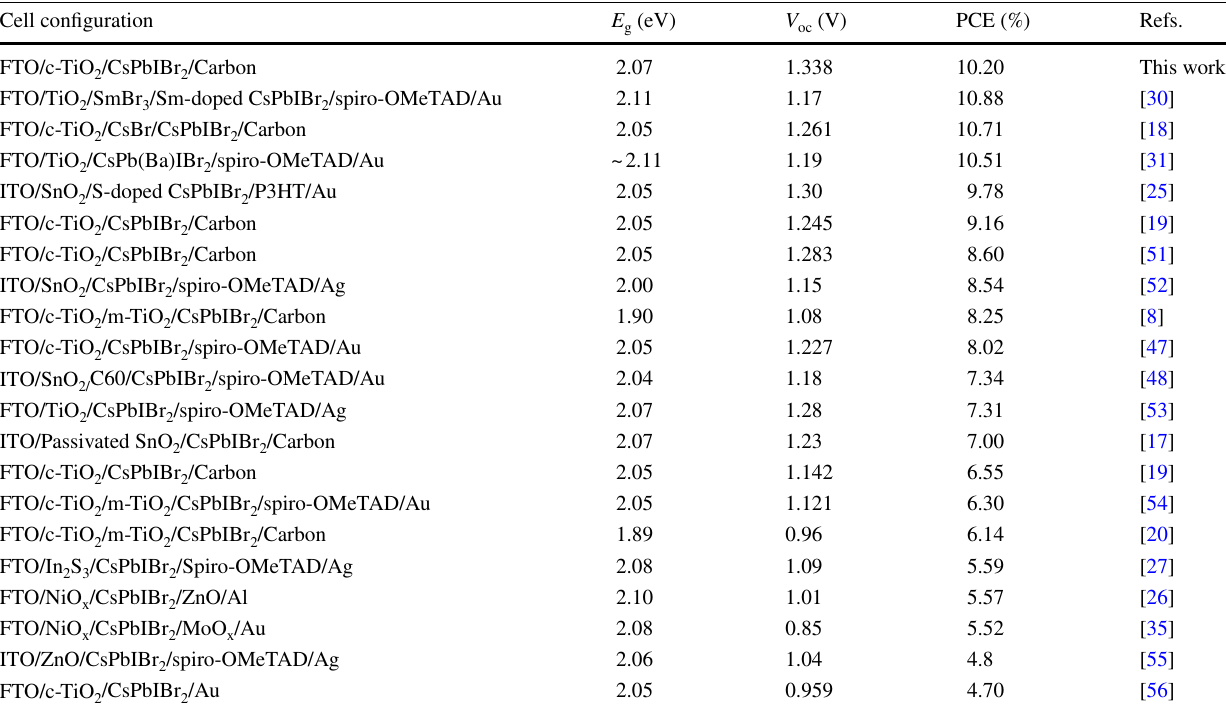
Table 2 Summary of V oc values and PCEs for CsPbIBr 2 PSCs reported so far Cell